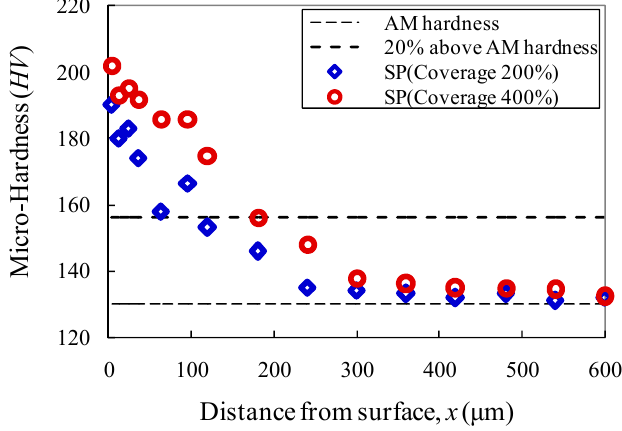
Figure 3. In-depth micro-hardness distribution of shot-peened specimens.